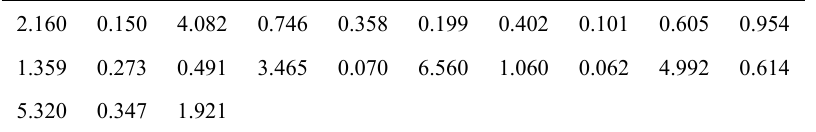
Times between failures (thousands of hours) of secondary reactor